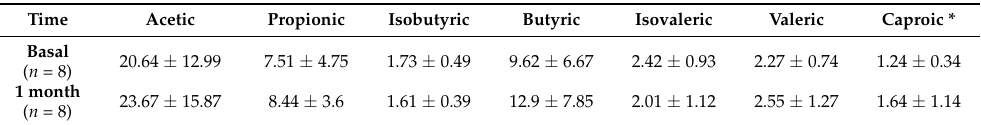
Table 2. Fecal fatty acids’ (FAs) concentration before and after the isoflavone treatment of the eight menopausal women of the study. Acetic